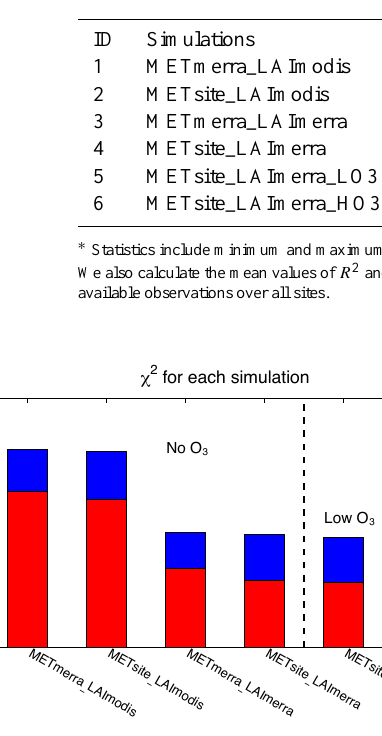
Figure 3. The calculated average χ 2 of GPP over NACP sites for Fig. 3. The calculated average χ 2 of GPP over NACP sites for 6 different simulations as 1068 six different simulations as listed in Table 2. The blue bars are re- listed in Table 2. The blue bars are results for all 40 NACP sites. The red bars are results 1069 sults for all 40 NACP sites. The red bars are results excluding sites excluding sites CA-Let, CA-NS1, US-Var, CA-SJ1, and CA-SJ2, where the simulated 1070 site-level χ 2 is larger than 16 as shown in Fig. S6a. 1071 CA-Let, CA-NS1, US-Var, CA-SJ1, and CA-SJ2, where the sim- 1072 ulated site-level χ 2 is larger than 16 as shown in Fig. S6a in the